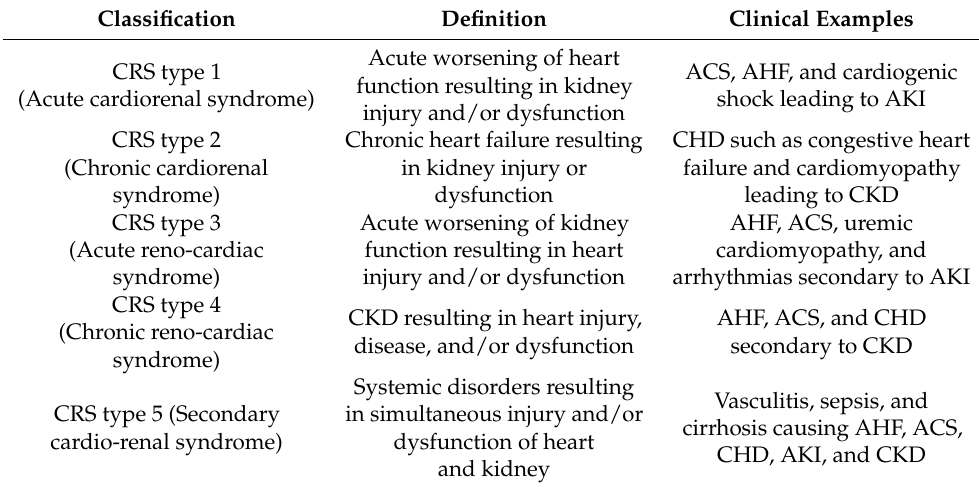
Table 2. Classification and definition of cardiorenal syndrome based on the